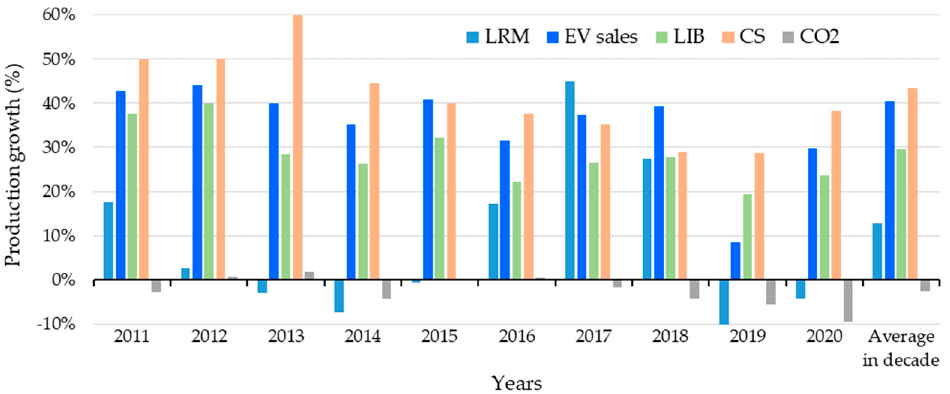
Figure 14. The annual trends of electric vehicle stock, electric vehicle sales, CO 2 emission from road transport, Lithium production, Lithium-ion battery, and charging stations.